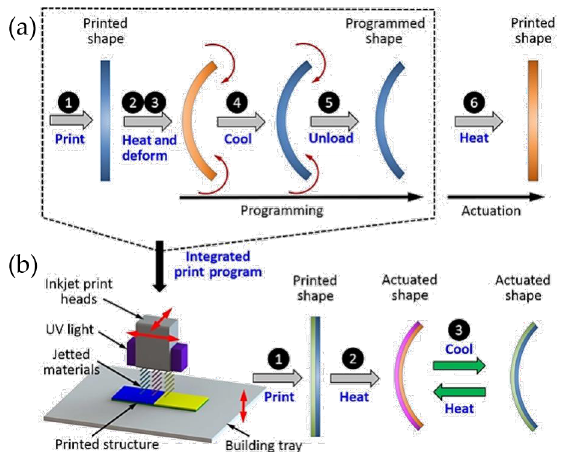
Figure 15. Demonstration of polyjet 4DP, ( a ) previous SMP-based 4DP requests five steps to achieve the programmed shape. ( b ) The direct 4DP approach allows for fabricating controlled multimaterial composites to integrate the five steps into a single one [187]. Copyright © 2017, Science.